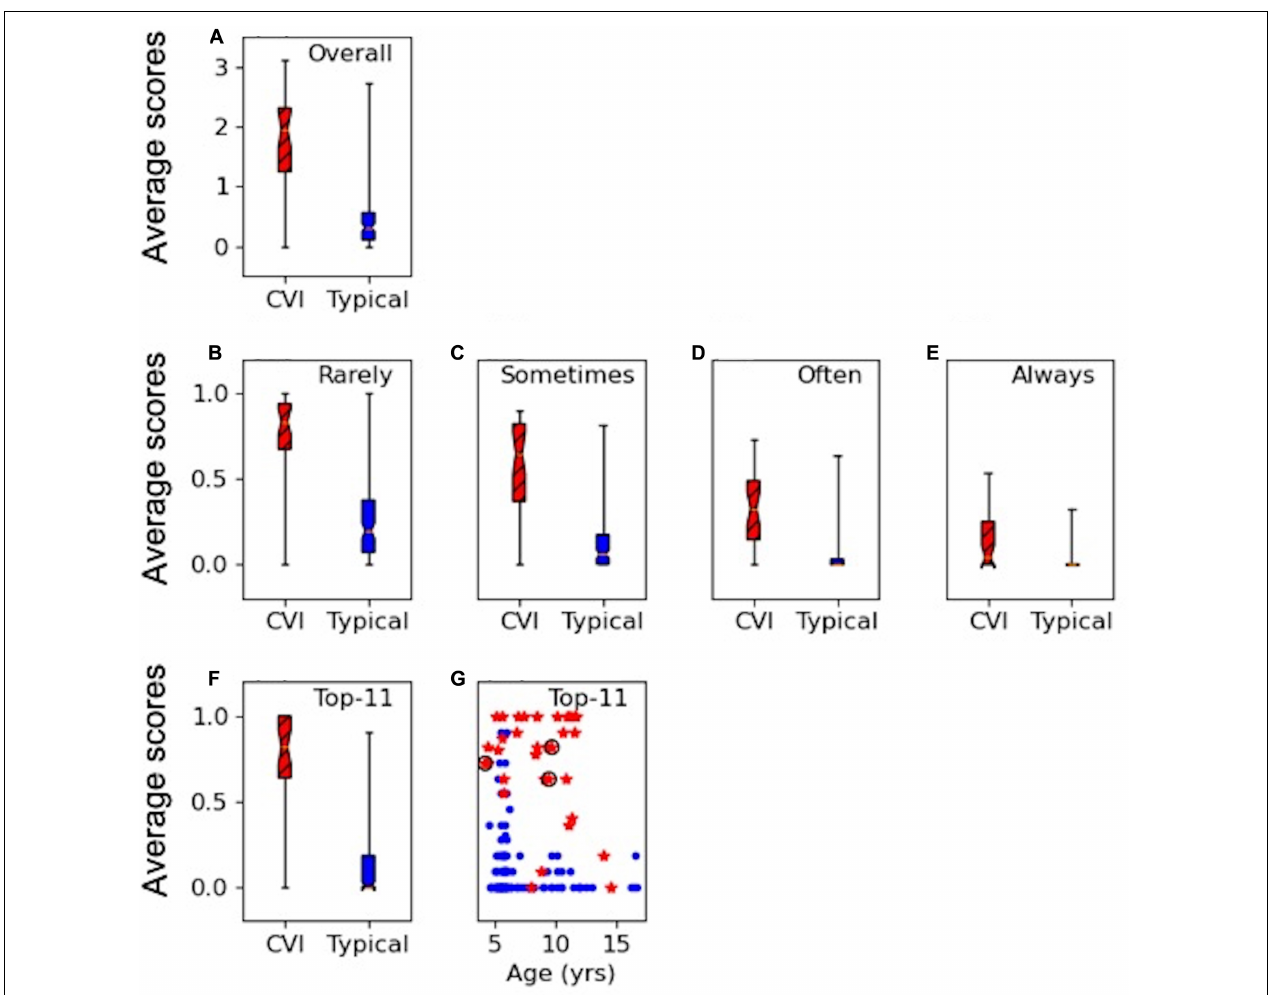
FIGURE 1 | HVFQI-51 scores for CVI (in red and hatched) and typical (in blue) groups. Boxplots show 25th and 75th percentile of group data with the median shown as the narrowest part of the box; whiskers show data range. (A) Full Likert overall scores for HVFQI-51. (B–E) Scores for HVFQI-51 for “Rarely,” “Sometimes,” “Often,” and “Always” dichotomies (see Table 3 ). (F) Scores for the Top-11 subset of HVFQI-51. (G) Individual scores for the Top-11 subset of HVFQI-51 for typical children (blue dots) and children with CVI (red stars) as a function of age (in years); data for 3 children whose binocular visual acuity was slightly worse than 0.2 are marked by black